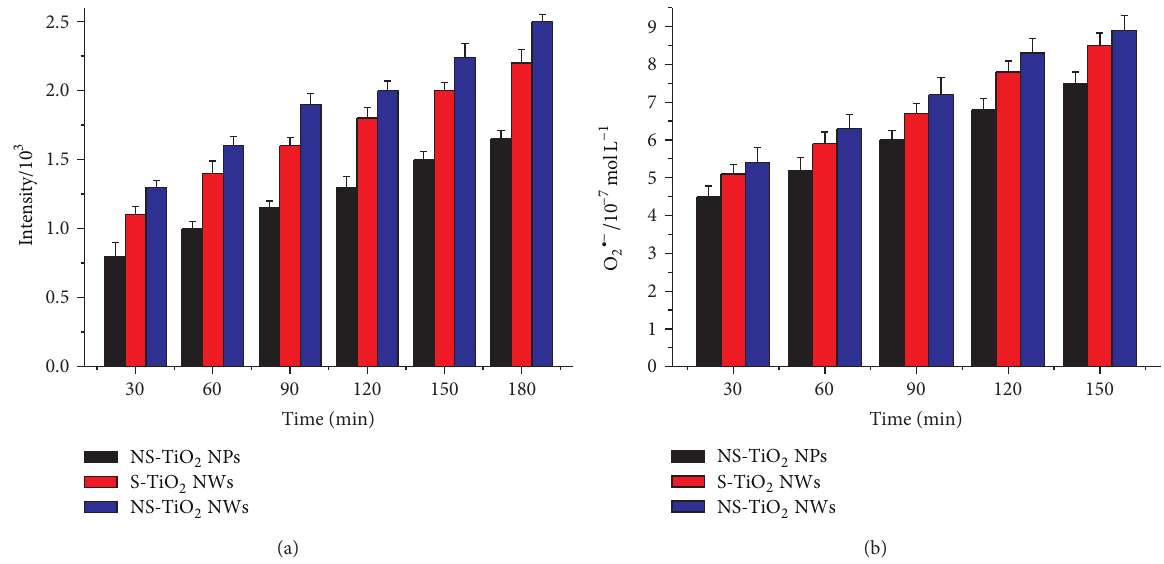
Figure 10: (a) ∙ OH-trapping PL intensity of NS-TiO 2 NPs, S-TiO 2 NWs, and NS-TiO 2 NWs in TA solution and (b) change of O 2∙− concentration for NS-TiO 2 NPs, S-TiO 2 NWs, and NS-TiO 2